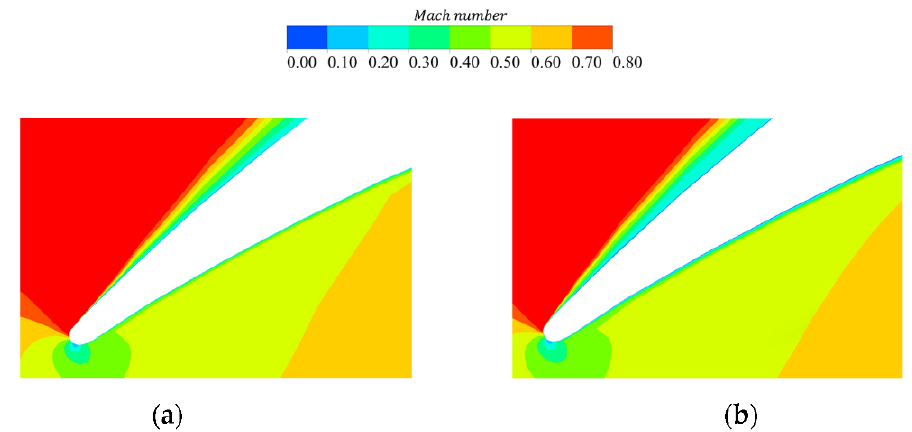
Figure 14. Comparison of the zoomed-in view of Mach number contours at the rotor blade leading edge at 10% spanwise location. ( a ) DIS case; ( b ) COUP case.